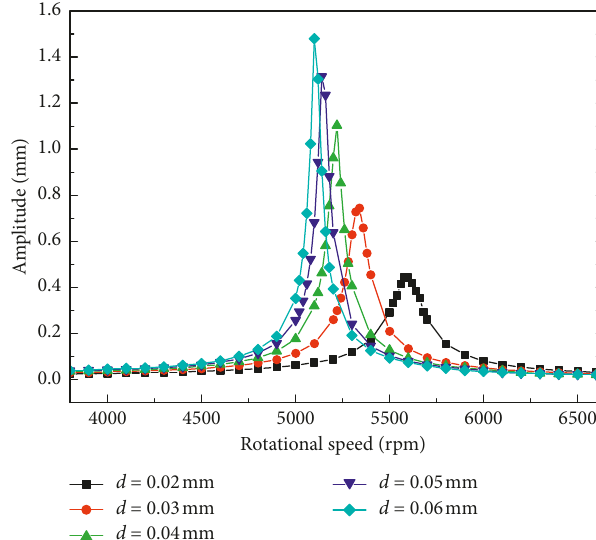
Figure 6: The influence of the gap between shrouds on the vi- bration characteristics.